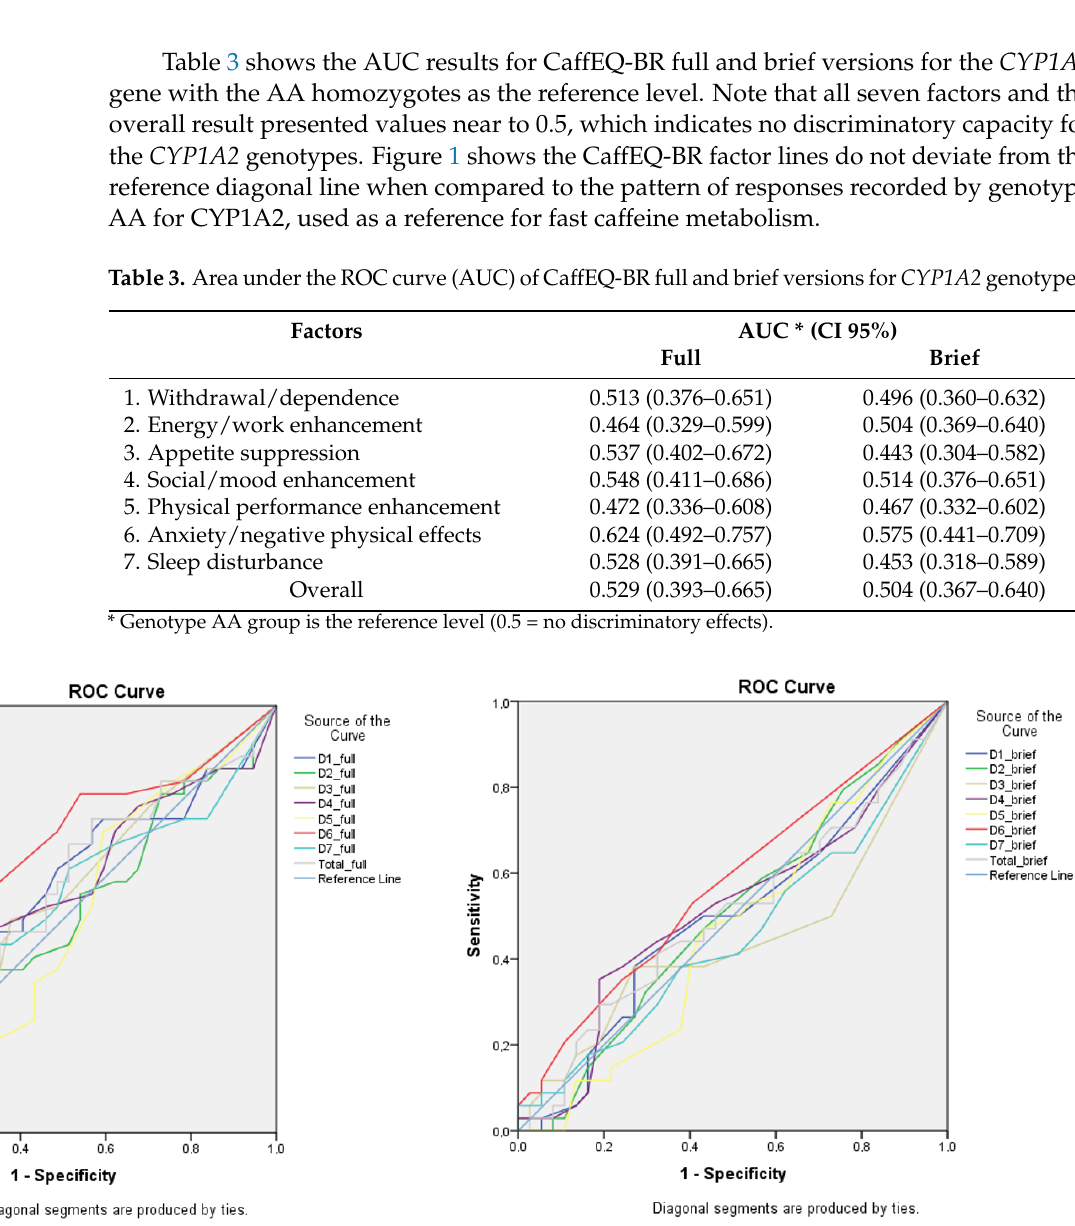
Figure 1. ROC curve of the CaffEQ-BR full ( left ) and brief ( right ) versions. The colored lines are the recorded scores of the 7 CaffEQ-BR factors for discrimination of the CYP1A2 genotypes considering AA group as the reference level (0.5 = reference diagonal line, no discriminatory for sensitivity or specificity). Factors: D1: withdrawal/dependence; D2: energy/work enhancement; D3: appetite